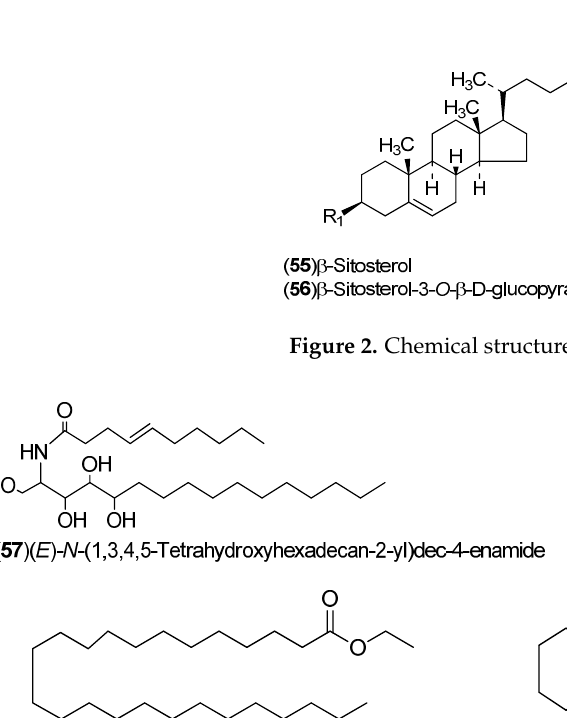
Figure 1. Chemical structures of flavonoids.